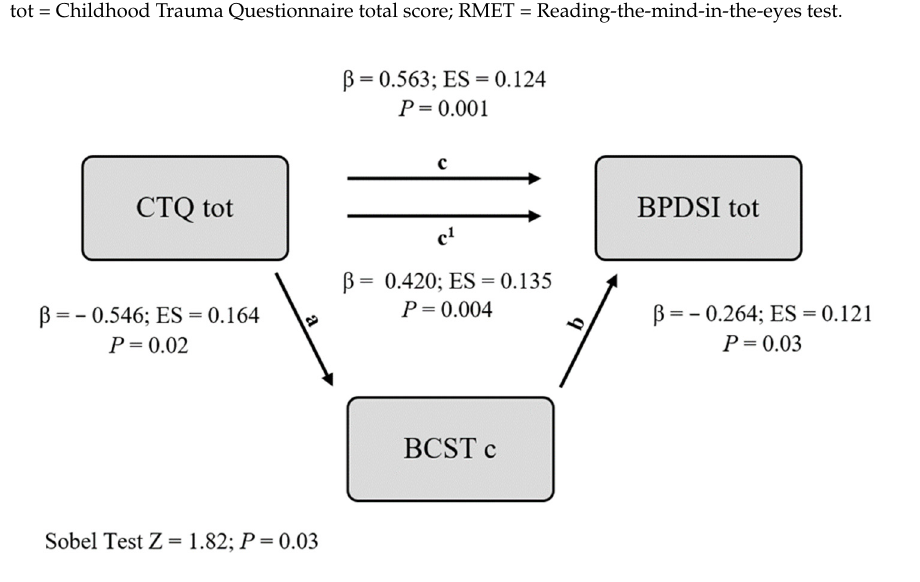
Figure 2. Mediational model (M = RMET). Table 3. Mediational model (M = BCSTc). β